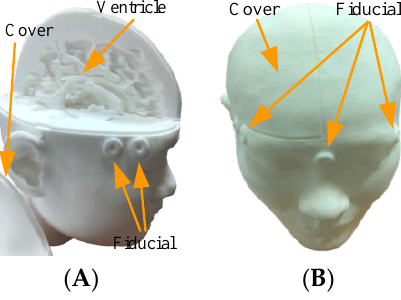
Figure 7. Patient-specific head phantom. ( A ) Head phantom with the ventricle. ( B ) Head phantom of combined appearance. This target information can optionally be manually set at the target position found by the surgeon. The AR scalp model is then loaded into the tablet APP.